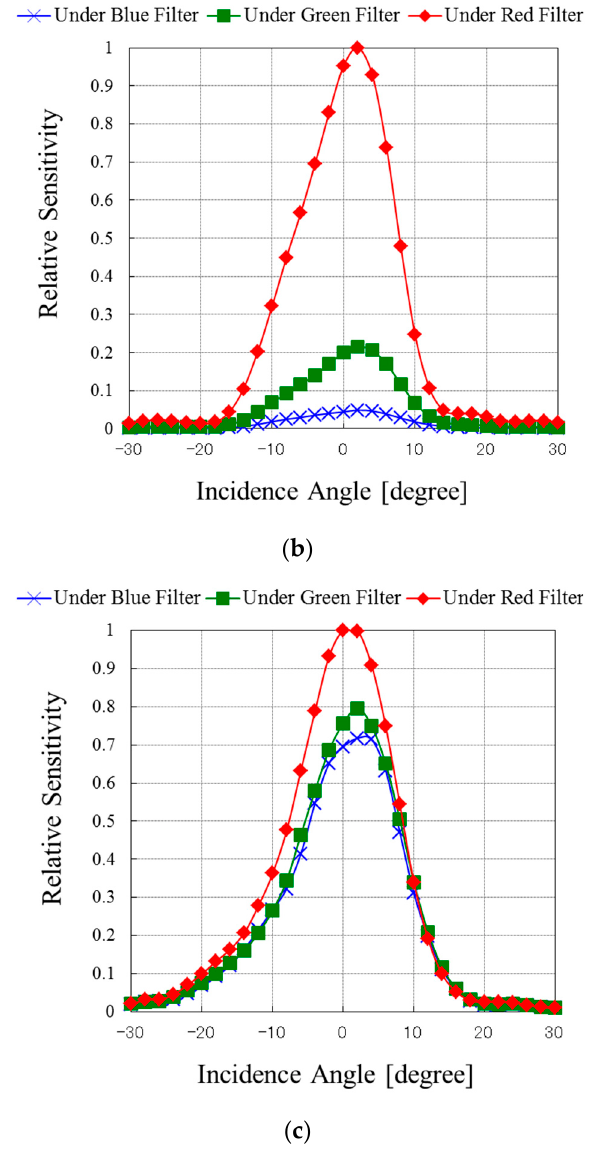
Figure 7. Angle dependence of normalized sensitivity of bottom PDs with ( a ) 560-, ( b ) 640-, and ( c ) 800-nm wavelength light.